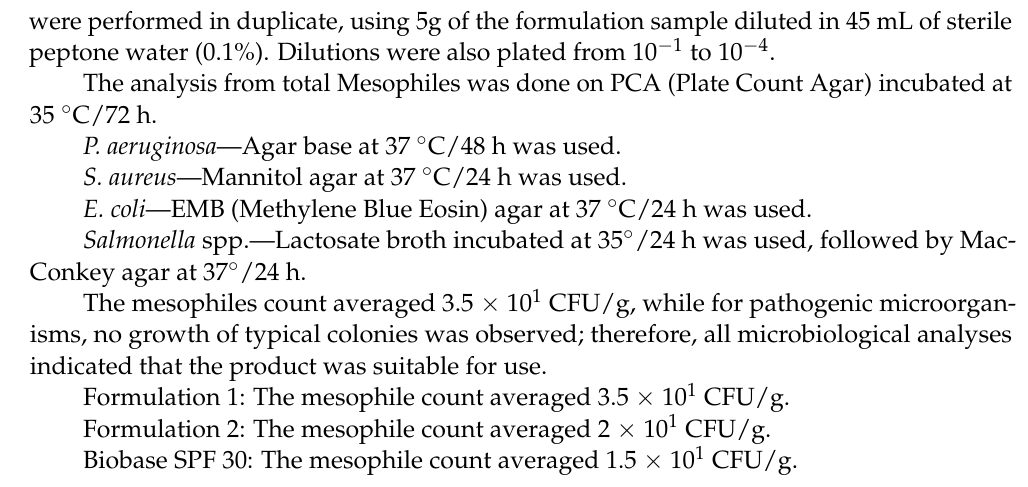
Formulation 1: The mesophile count averaged 3.5 × 10 1 CFU/g. Formulation 2: The mesophile count averaged 2 × 10 1